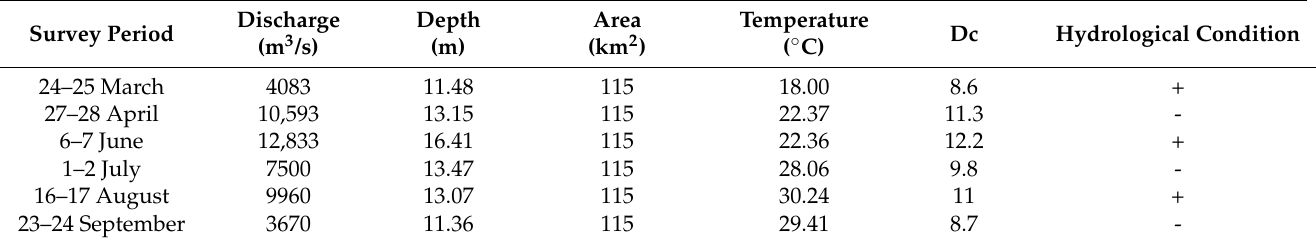
Table 1. Data from acoustic surveys in the Xijiang River section (middle and lower main stream of the Pearl River) under different hydrological